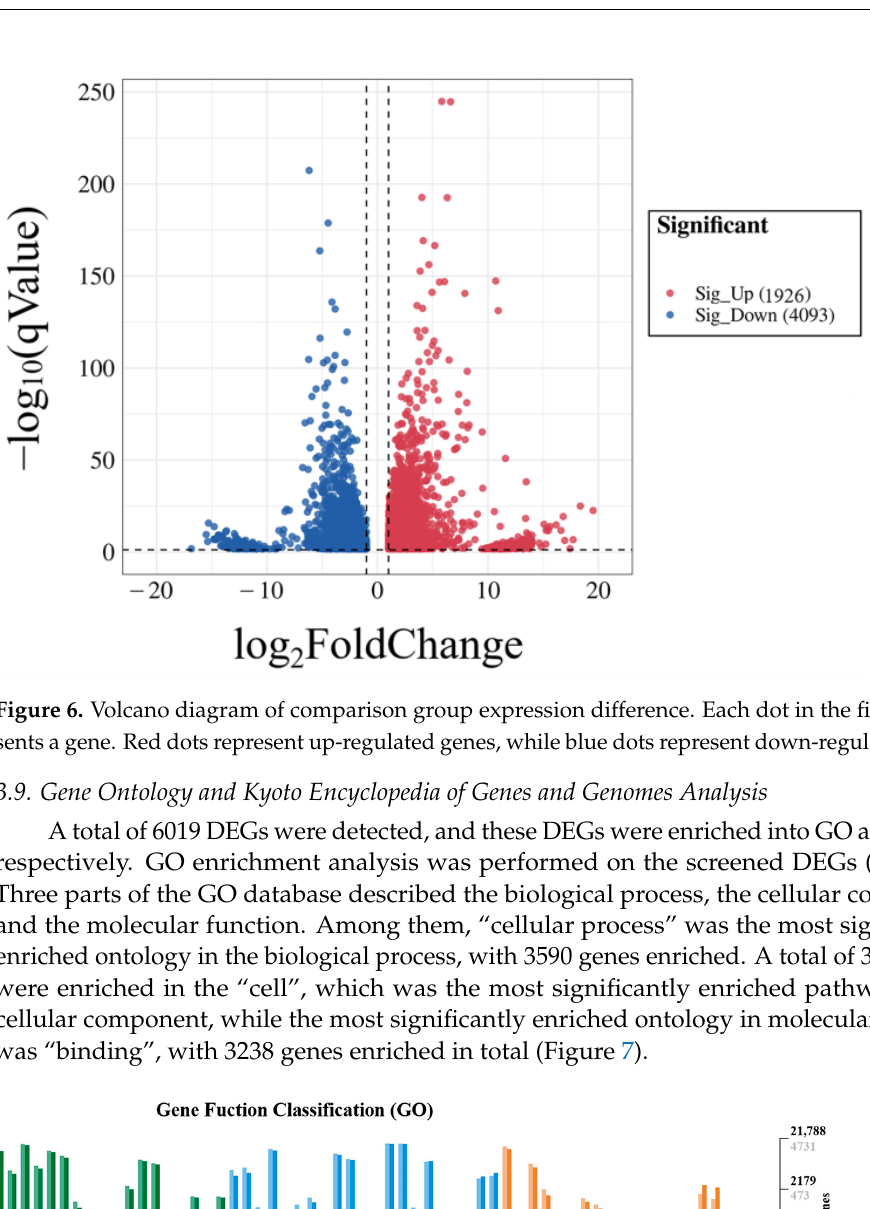
Figure 7. Histogram of GO annotation classification of differential genes. The horizontal axis is functional classification, and the vertical axis is the number of genes in the classification (right) and their percentage in the total number of genes annotated (left). Different colors represent different categories. On the bars and axes, the light colors represent DEGs and the dark colors represent all genes. KEGG enrichment results showed that 1499 DEGs were enriched in the KEGG pathway. According to the p -values from small to large, the top 20 KEGG pathways with the most significant differences were selected to draw Figure 8. Among the top 20 KEGG pathways, 10 pathways were immune-related. The most significantly differential pathway